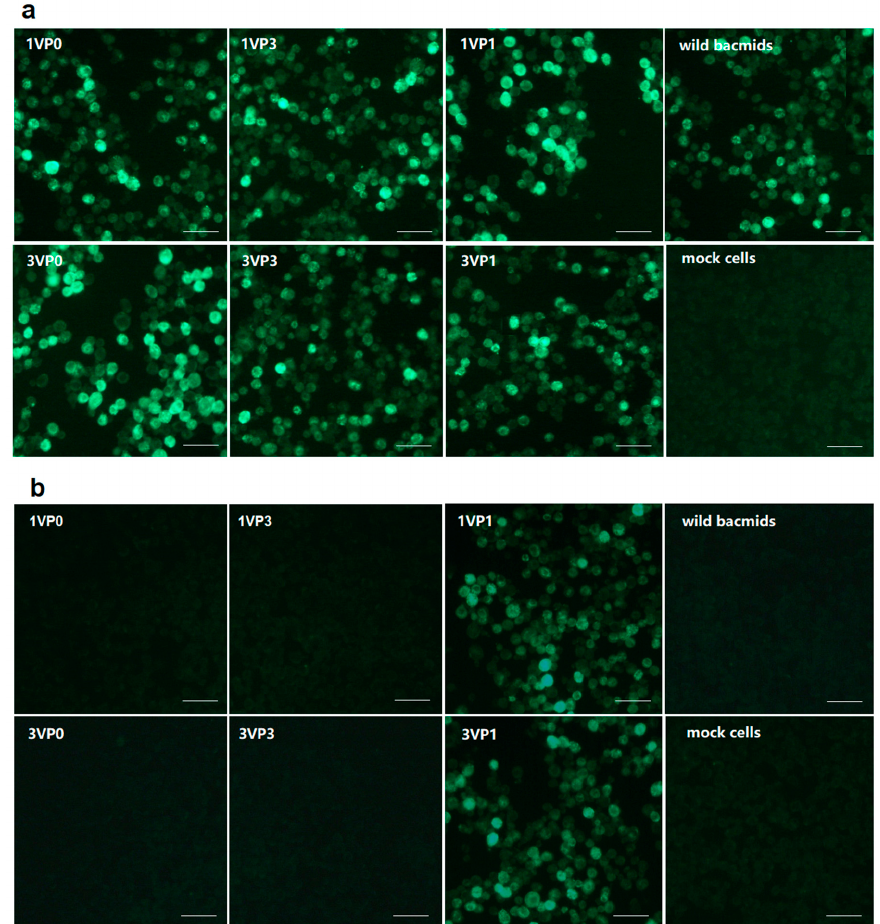
Figure 1. The VP1, VP0, and VP3 proteins of DHAV-1 and DHAV-3 expressed in Sf9 cells were detected by immunofluorescence assay (IFA): ( a ) the Sf9 cells transfected by the different recombinant bacmids (1VP0, 1VP3, 1VP1, 3VP0, 3VP3, 3VP1) were detected by IFA with anti-His mAb, respectively; ( b ) the Sf9 cells transfected by the different recombinant bacmids were detected by IFA with mAb 4E6, respectively. Bars, 100µm.